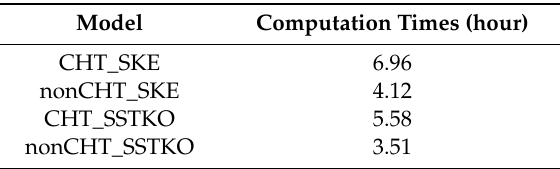
Table 6. Computational